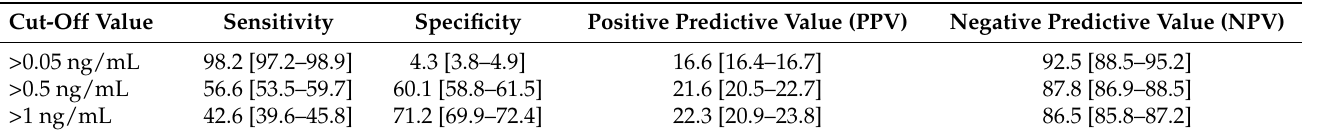
Table 5. Sensitivity and specificity for different cut-off values of PCT at Emergency Department admission for non-septic presentation in ED (NSep group), for all-cause in-hospital death. Overall ROC AUC was 0.607 [0.595–0.619]. The best discriminating value according to Youden index J was PCT > 0.42 ng/mL.